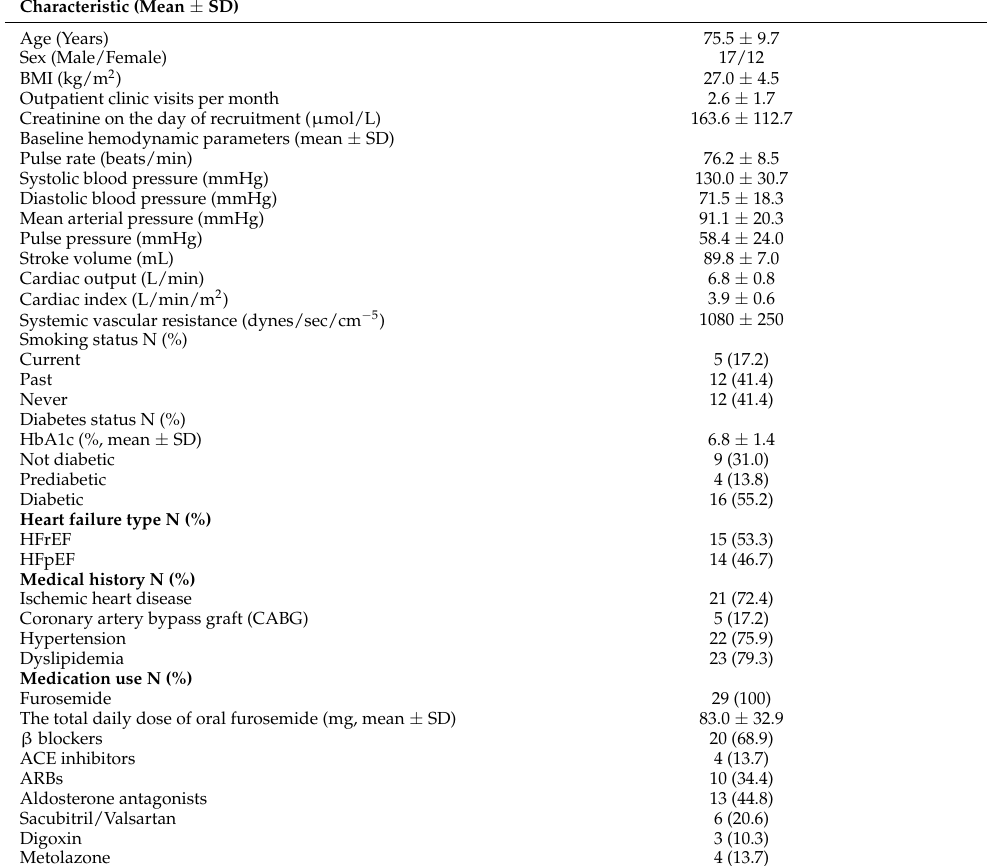
Table 1. Demographic and baseline hemodynamic characteristics of the patients included in the study ( n = 29). BMI, body mass index; HbA1c, Hemoglobin A1c; SPO 2 , blood oxygen saturation; HFrEF, heart failure with reduced ejection fraction ( ≤ 40%); HFpEF, heart failure with preserved ejection fraction (>40%); CABG, coronary artery bypass graft; ACE, angiotensin-converting enzyme; ARBs, angiotensin receptor